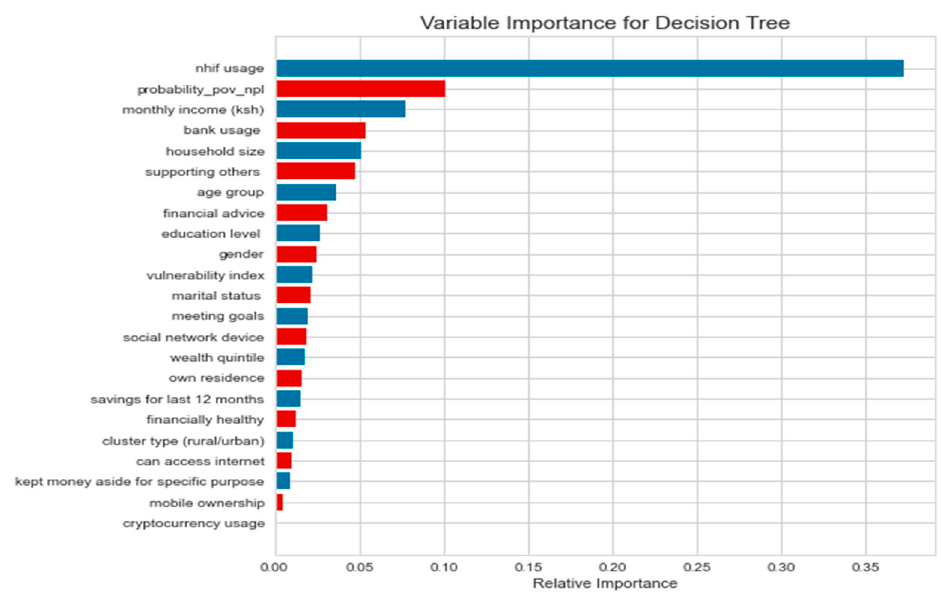
Figure 7. Feature importance from decision tree.